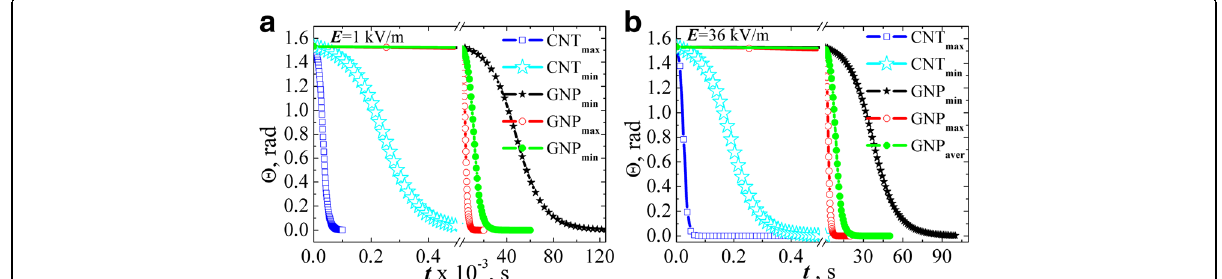
Fig. 8 The evolution of the angle of carbon filler particles inclination relative to the field direction estimated in ellipsoids approximation for MWCNTs and in spheroid approximation for GNPs at AC electric field strength 1 kV/m ( a ) and 36 kV/m ( b